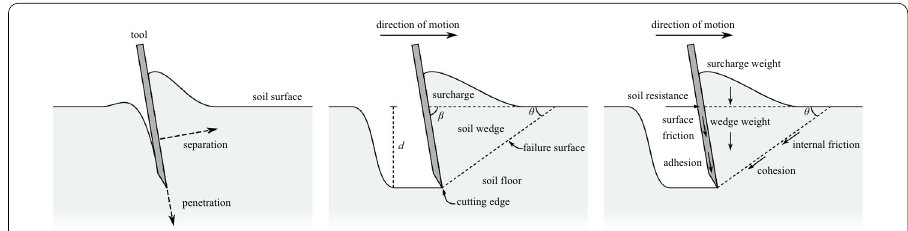
Fig. 1 Illustration of a blade interacting with a soil bed. There are two modes of operation, penetration, and separation (left). The failure surface form a wedge-shaped active zone (middle). When a blade cut the soil there are many forces contributing to the soil resistance